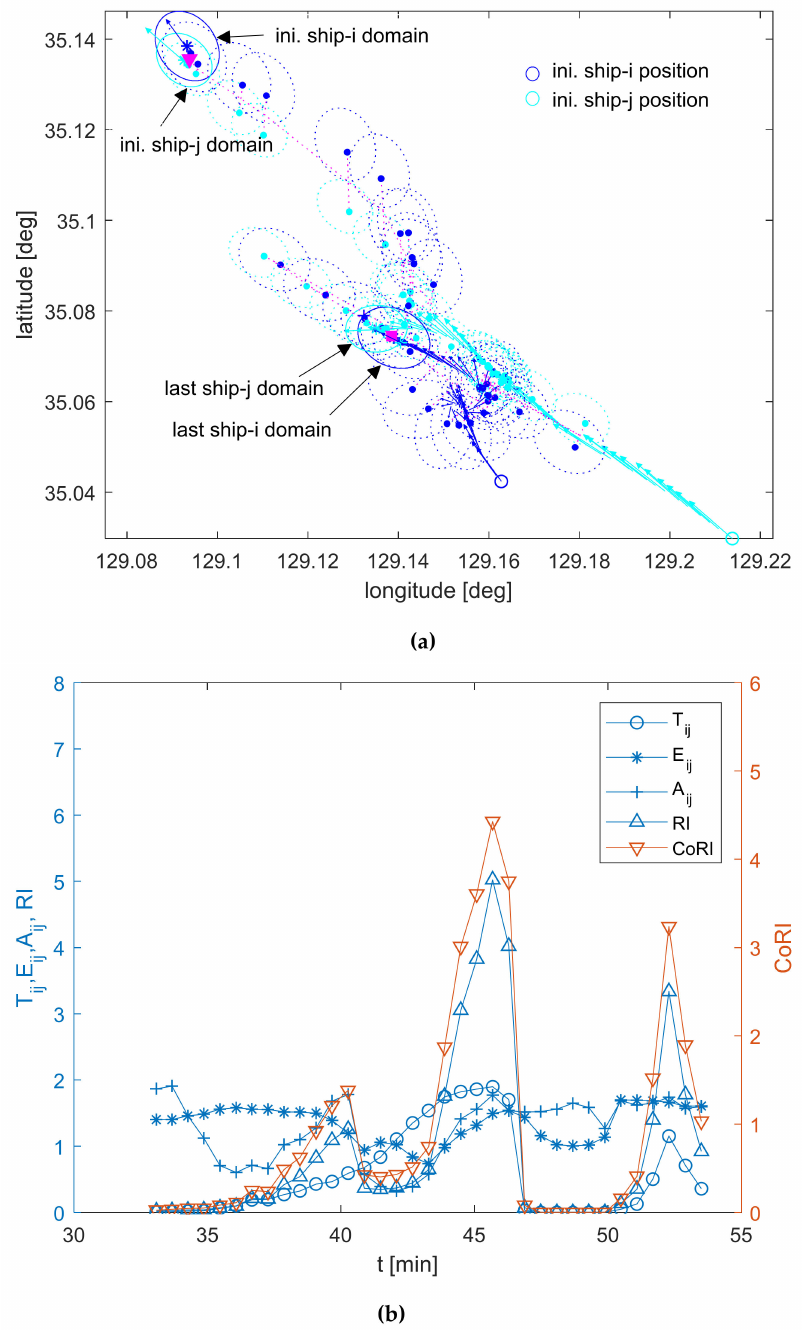
Figure 5. ( a ) Ship tracks with VTSO ship domain at CPA position ( · : CPA position, ← : 3-min vector); ( b ) CoRI results with T, E, and A indices of scenario no.4 ( ship-i : ship-1, ship-j :